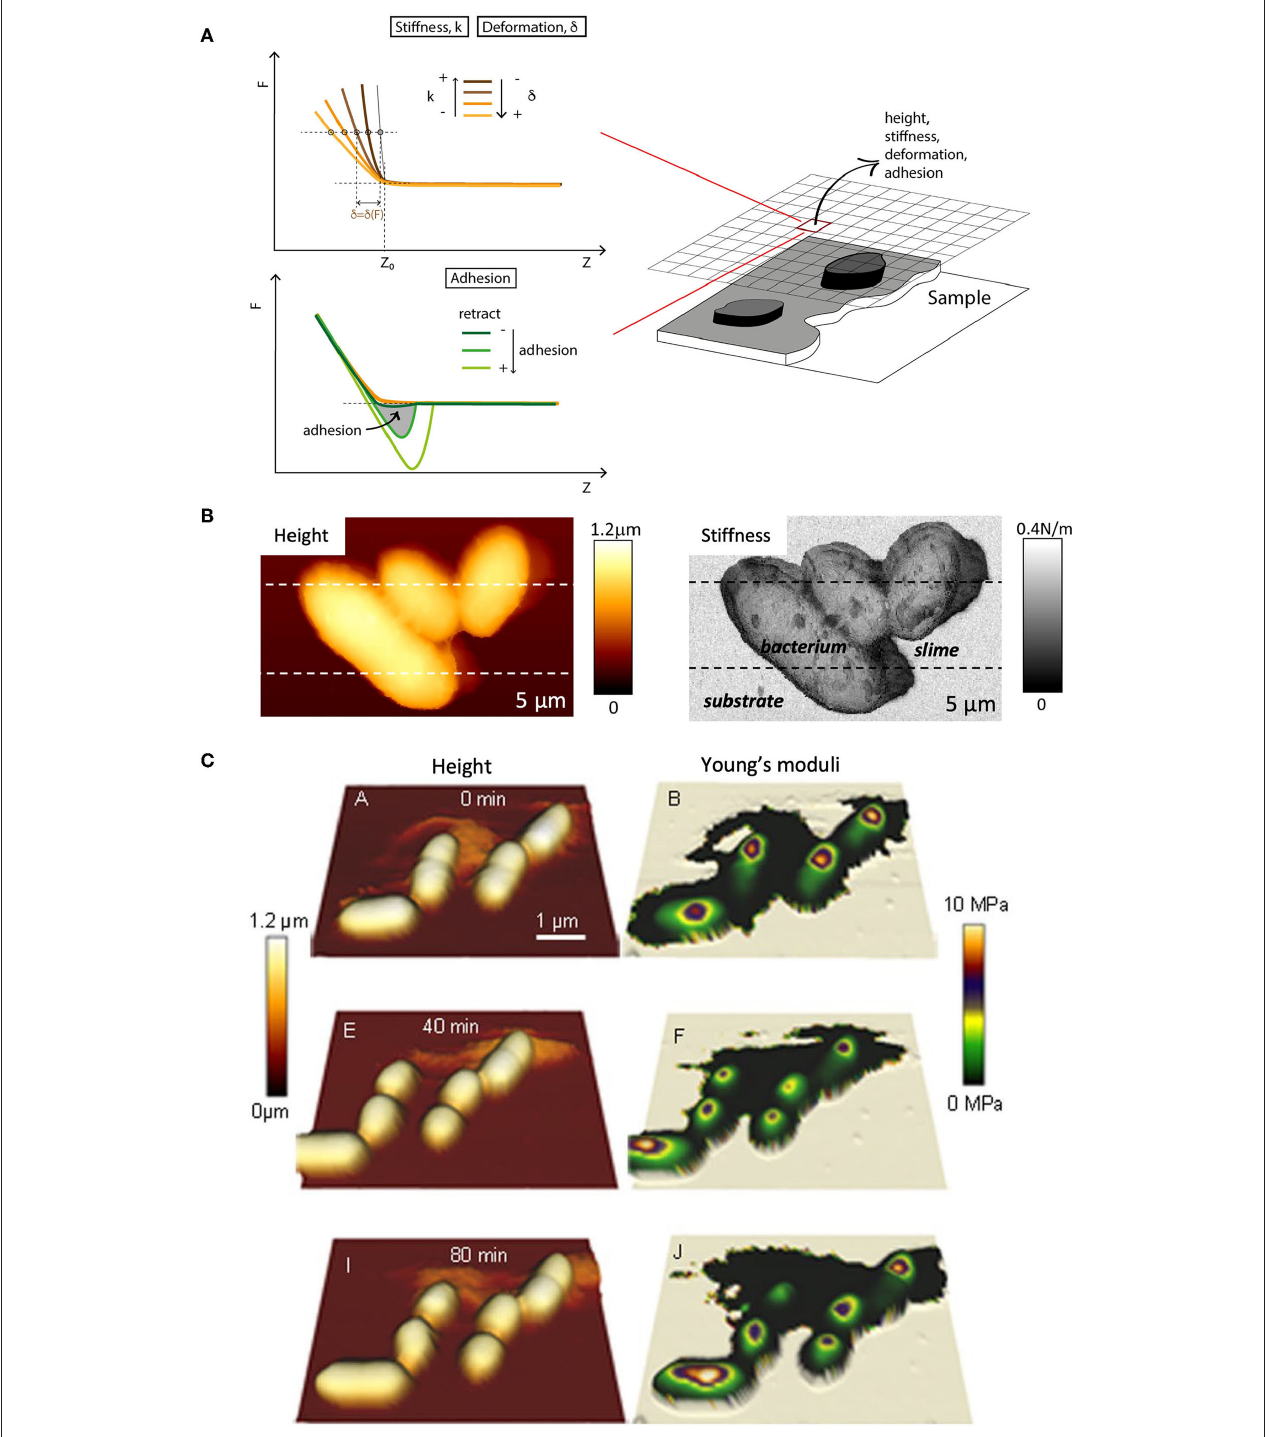
FIGURE 11 | Multiparametric imaging on the fly. (A) Generation of multiplexed data from AFM force-displacement curves. Stiffness are computed as slopes from linear fits of parts of the loading curve contact region (traces in shides of orange). The fitting limits are either preset or readjusted a posteriori (graphics adapted from Moreno-Flores and Toca-Herrera, 2013, fig. 7.9). (B) Height and stiffness maps of motile bacterial leaving a trace of, presumably, slime of distinctive softness (figure reproduced from Dhahri et al., 2013 with permission 2 ). (C) Time-lapse topological and mechanical maps of single bacteria ( E. Coli ) undergoing cell division. The Young moduli were calculated according to the Hertz model via a data analysis software of the AFM manufacturer (figure reproduced from Bhat et al., 2018 with permission 2 ).